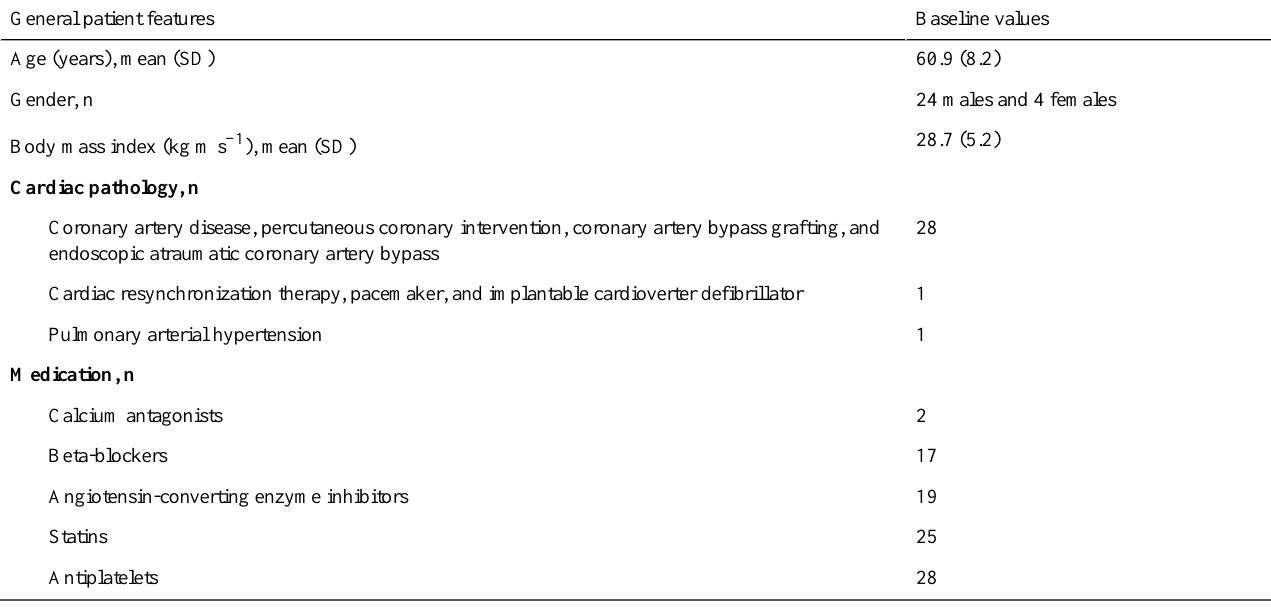
Baseline valuesGeneral patient features